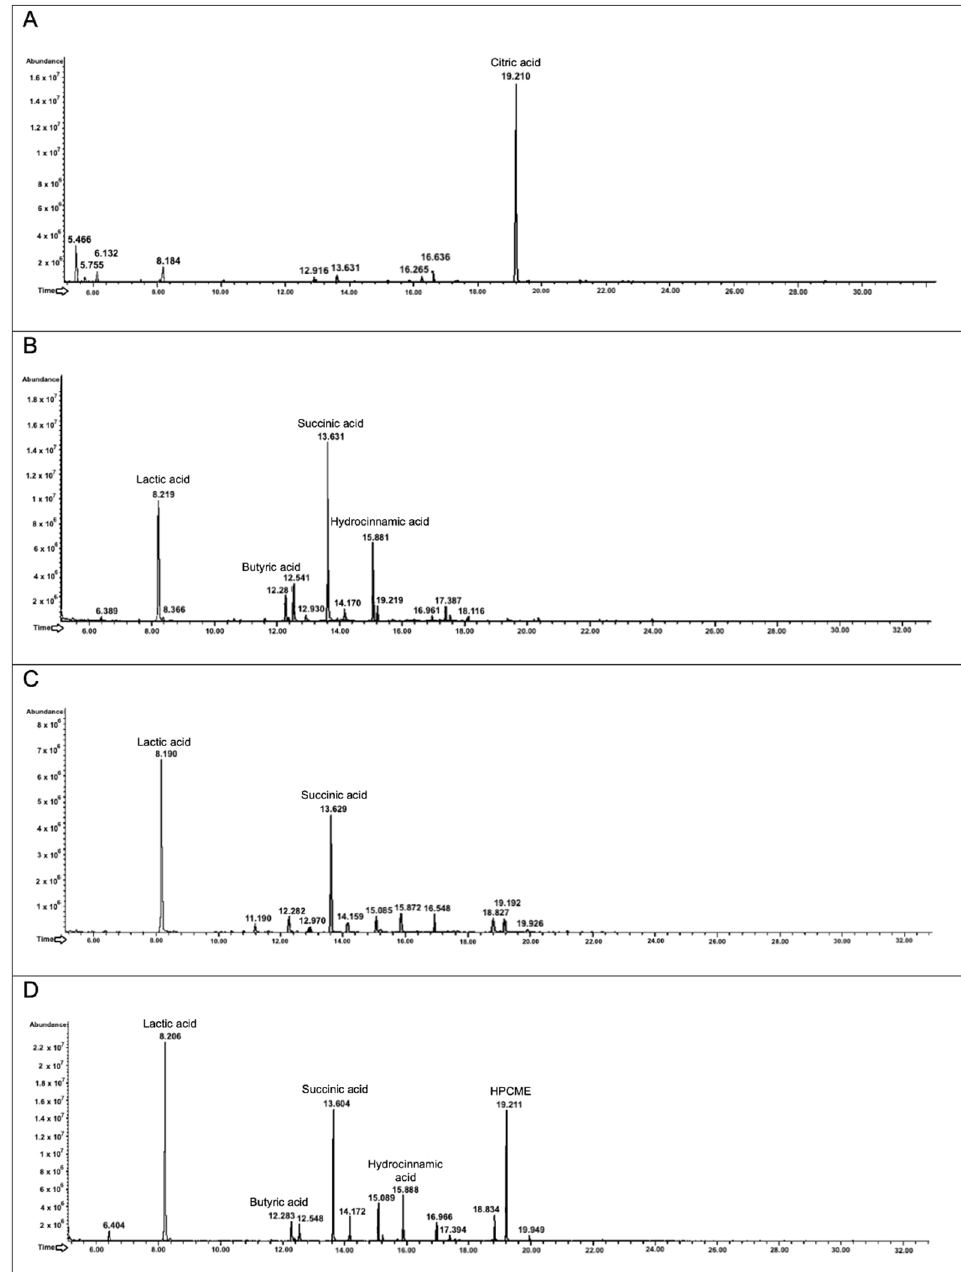
Figure 6. Secondary metabolites produced after the growth in presence of polyphenol-rich cinnamon bark extract of L. plantarum , B. animalis subsp. lactis , and probiotic consortium. The figure represents the chromatograms obtained through GC-MSD analysis. L. plantarum , B. animalis subsp. lactis , and the probiotic consortium were incubated for 48 h in presence of the polyphenol-rich cinnamon bark extract (1% w/v ). Panel ( A ) represents the extracted polyphenol-rich cinnamon bark extract, while the identified intermediate metabolites are reported in ( B ) for L. plantarum , ( C ) for B. animalis subsp. lactis , and ( D ) for the probiotic consortium.